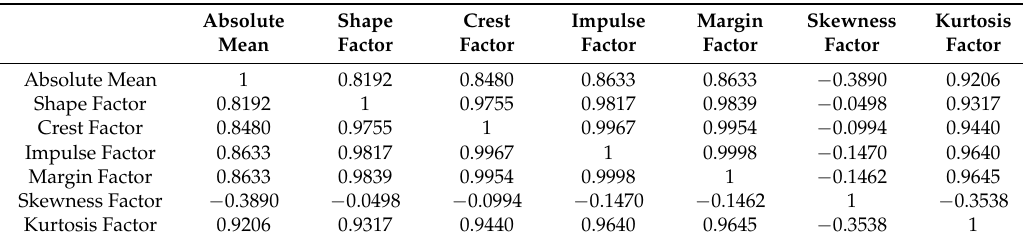
Table 10. Pearson correlation coefficients between